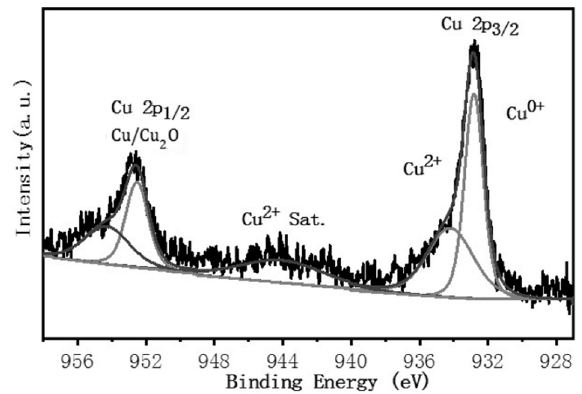
Figure 10. The Cu 2p1/2 at 952.5 eV and Cu 2p3/2 peaks at 934.2 eV can be explained by the existence of Cu/Cu 2 O and CuO.